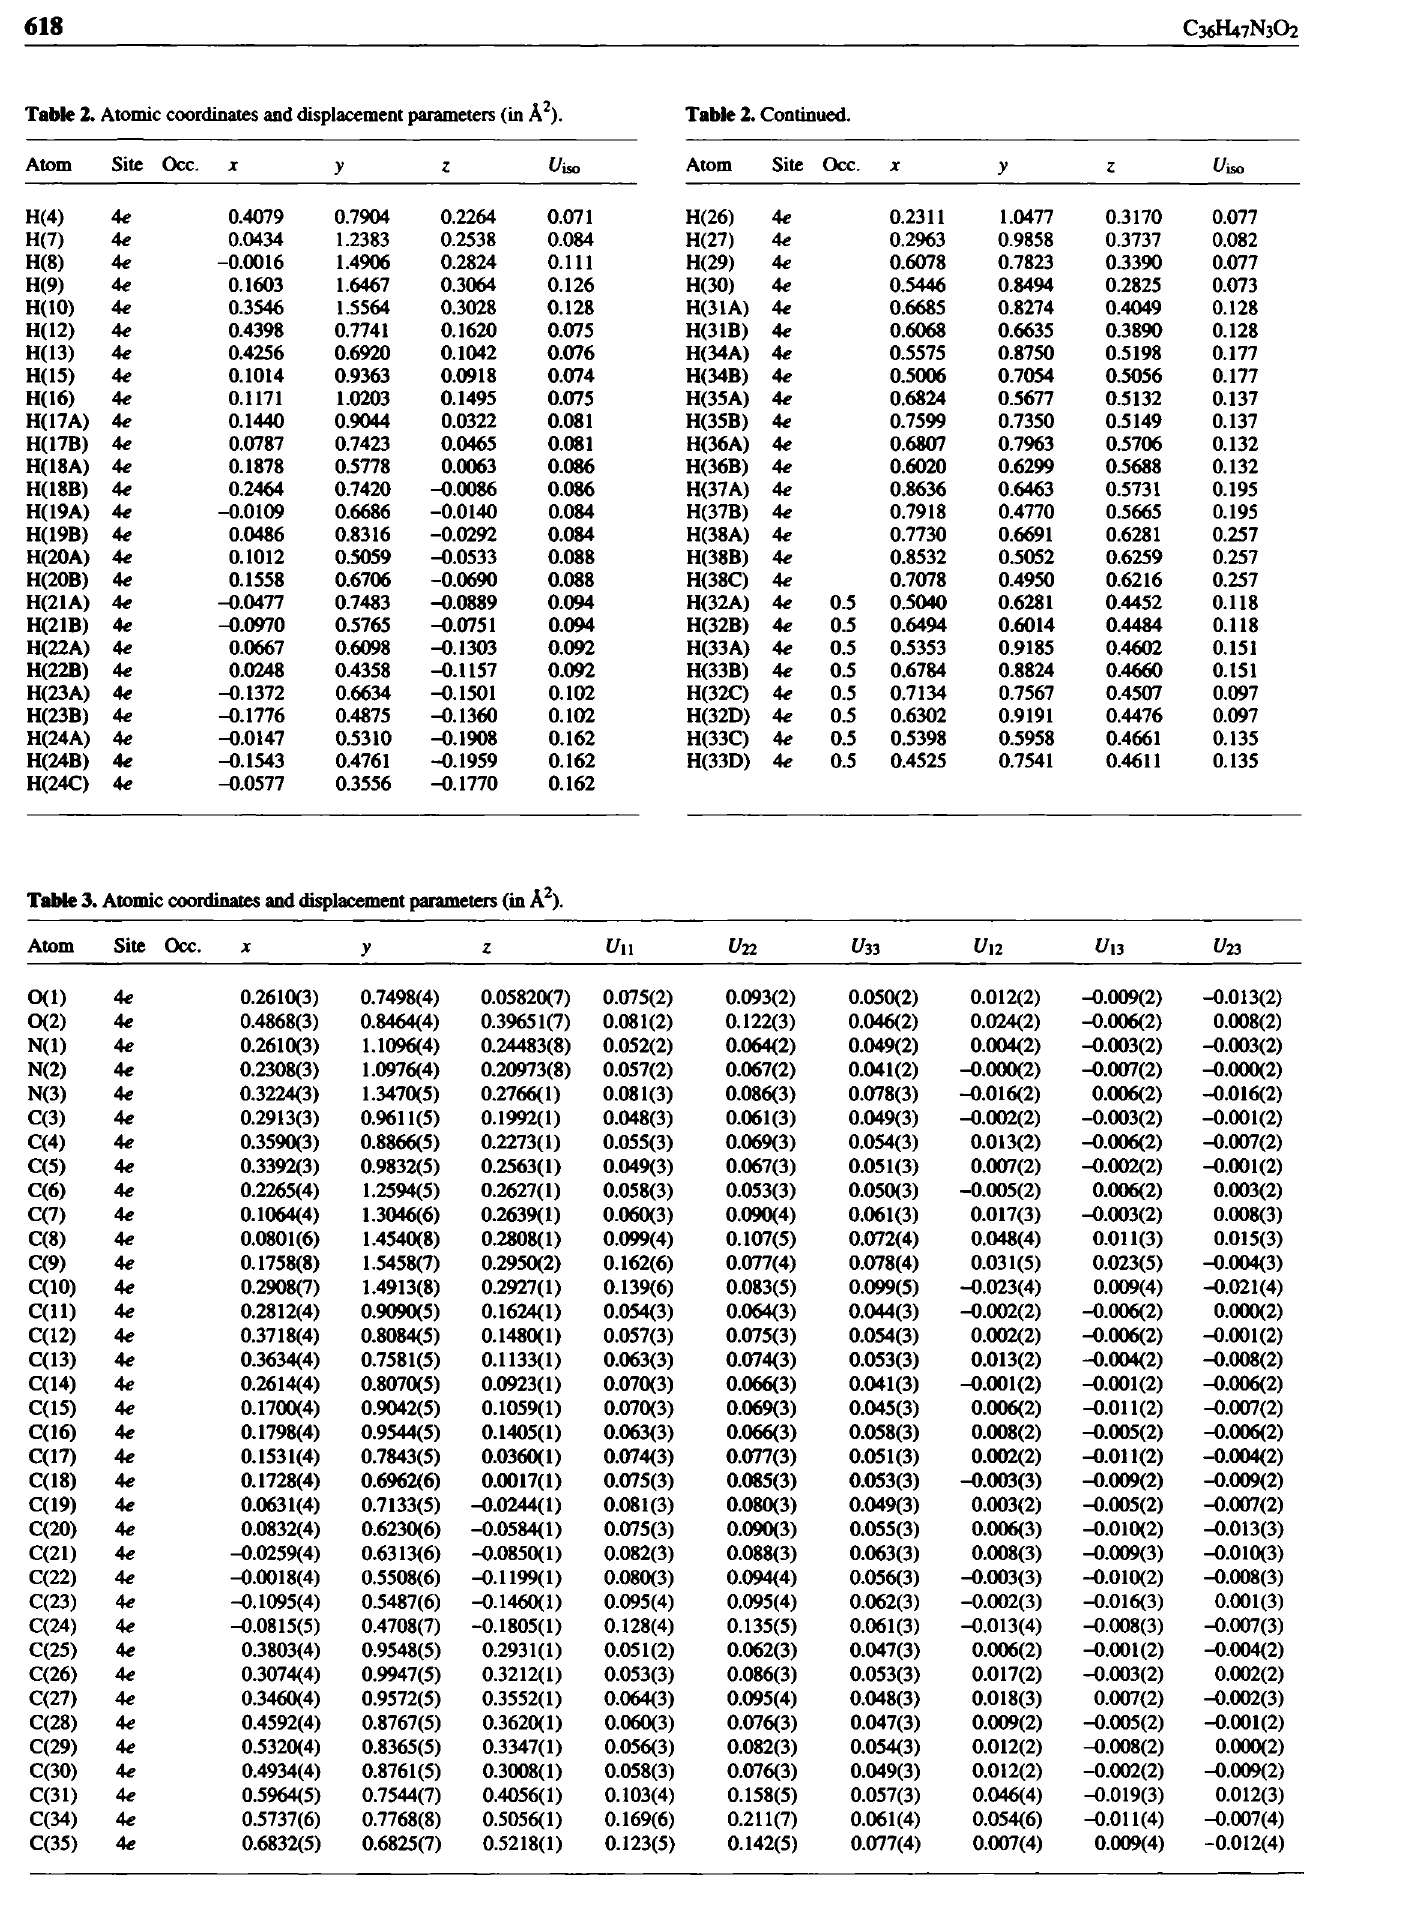
Table 2. Atomic coordinates and displacement parameters (in A 2 ).